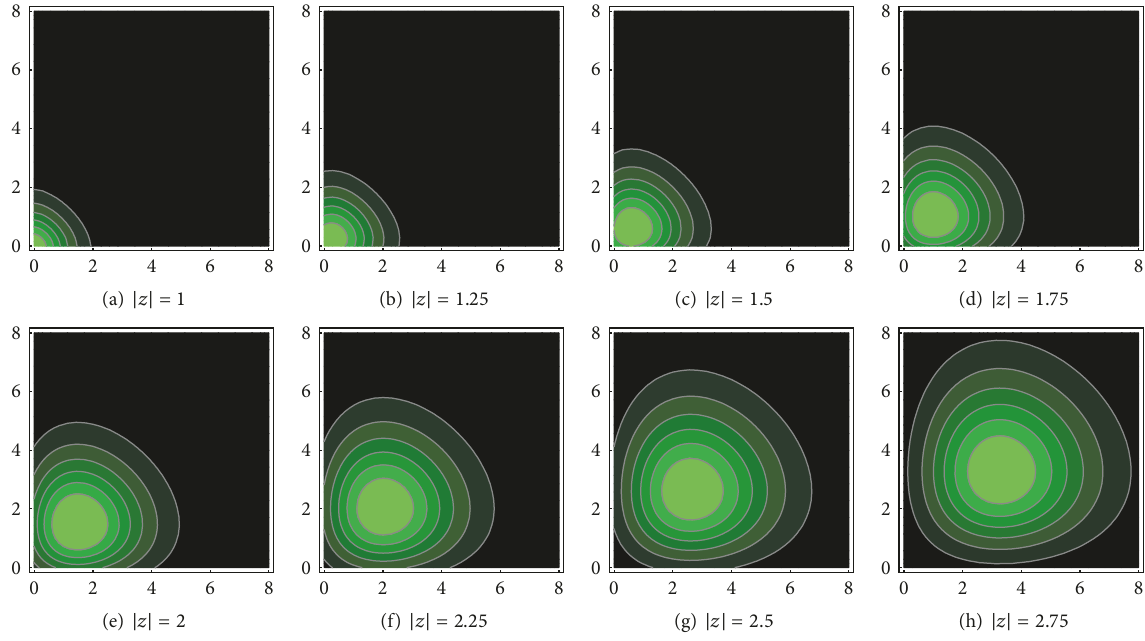
Figure 4: The distribution P (𝑛,𝑚,|𝑧|) in the 𝑛𝑚 -plane for the indicated values of |𝑧|